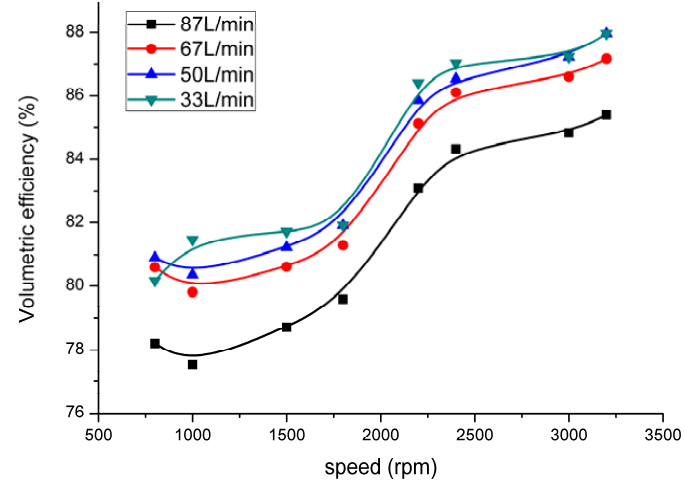
Figure 5. Variation of volumetric efficiency under different rotational speeds.